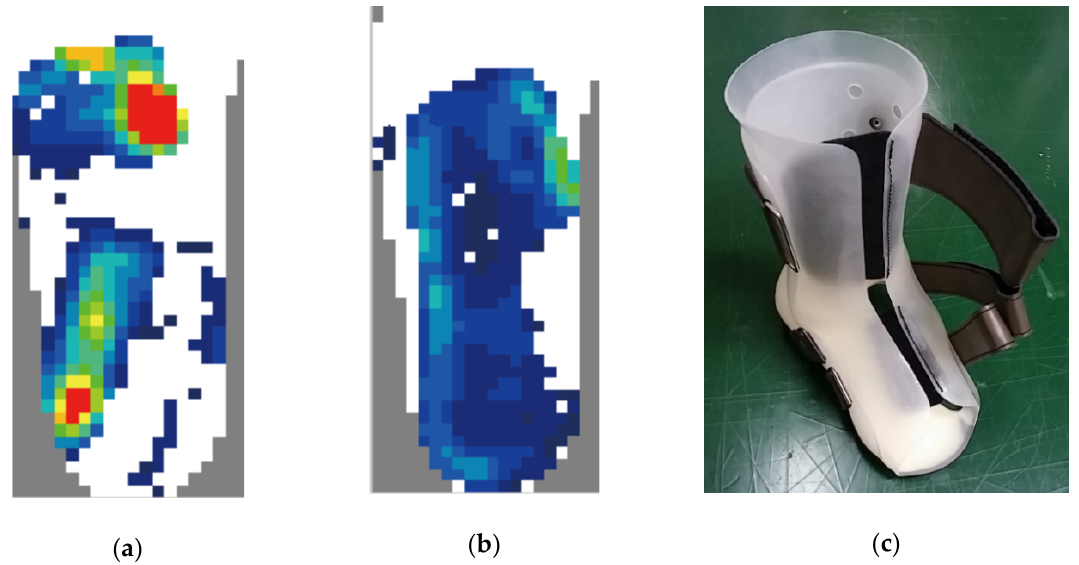
Figure 3. Depressurization with precision orthotic treatment in Case B. Dynamic plantar pressure without ( a ) and with ( b ) orthosis is shown. The pressure distribution became equalized over the entire plantar surface. ( c ) A picture of orthosis.